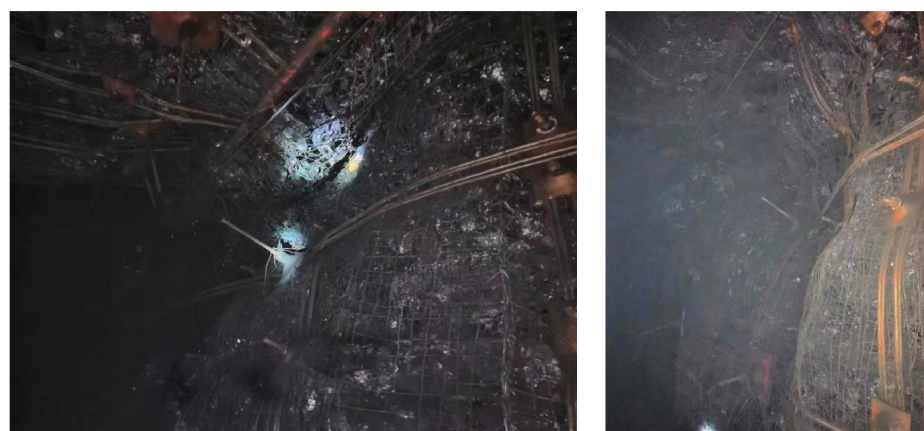
Figure 9: Deformation of the roadway surrounding the rock masses.